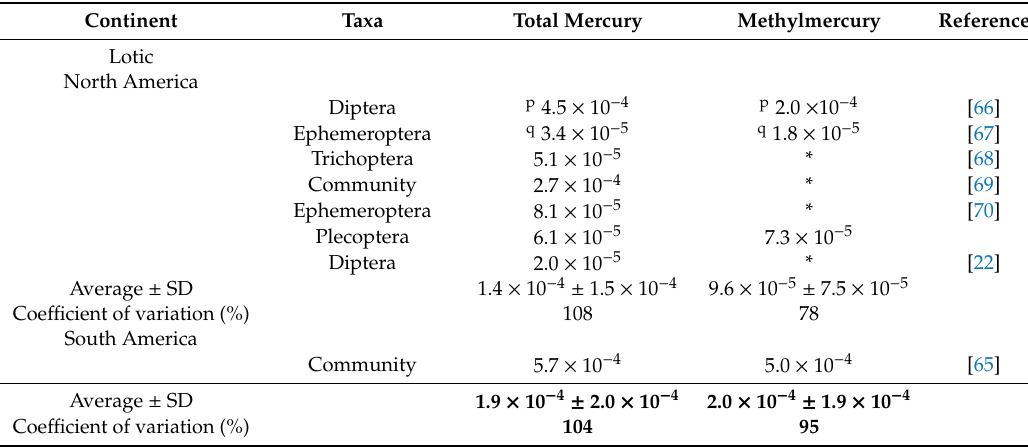
Table 5. Total mercury (Hg, mg g − 1 of dry mass) and methylmercury (MeHg, mg g − 1 ) in emergent aquatic insects in rivers. ‘Community’ denotes instances where whole taxa values are reported. Average and coe ffi cient of variation (in bold) represents the grand average that was used to calculate emergence for Africa, Asia, Australia, Europe, and South